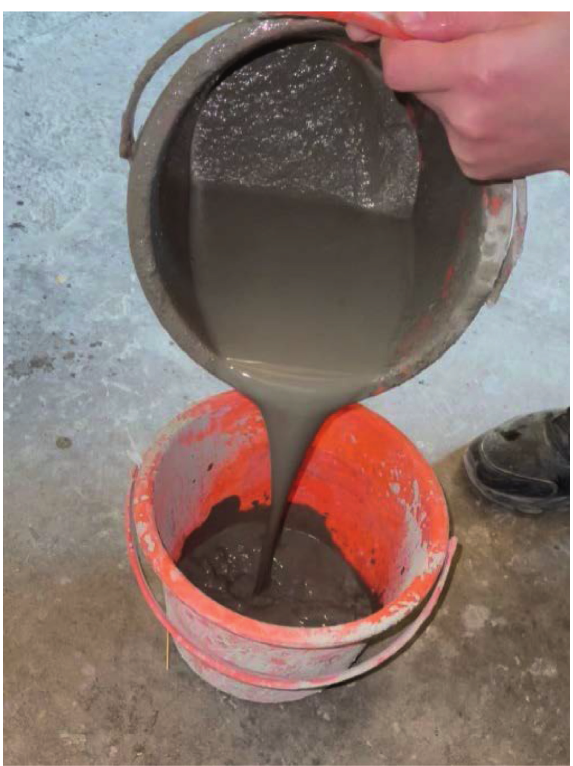
Figure 9: Flow pattern of filling